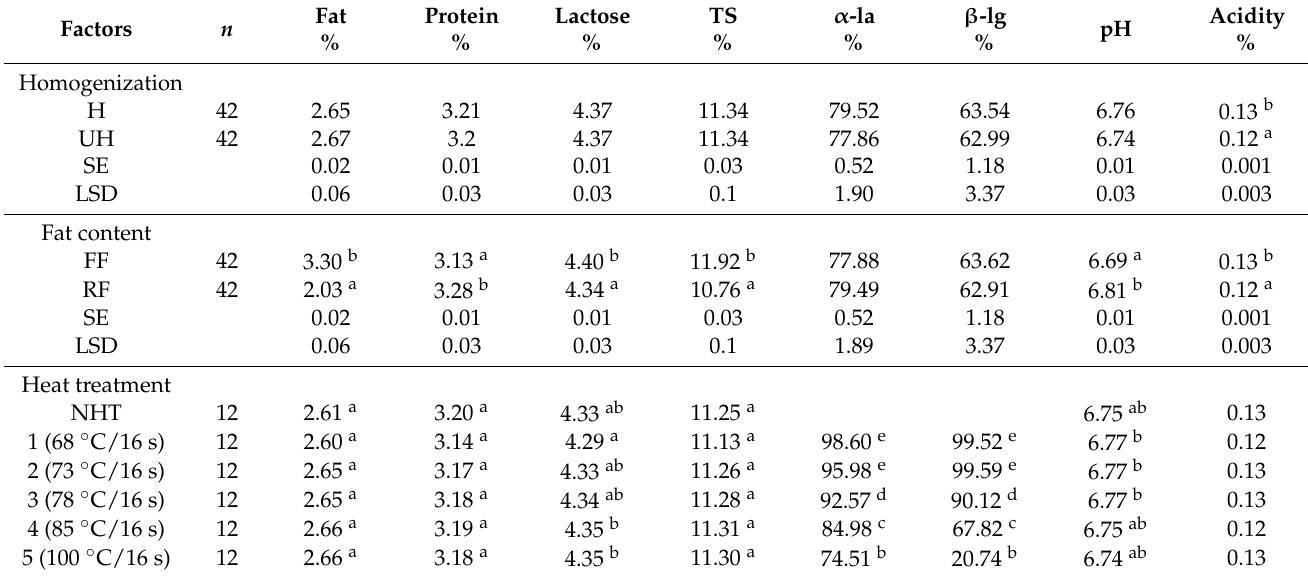
Table 1. Means of compositional parameters and residual native whey proteins of cheese milk used in the experiments.